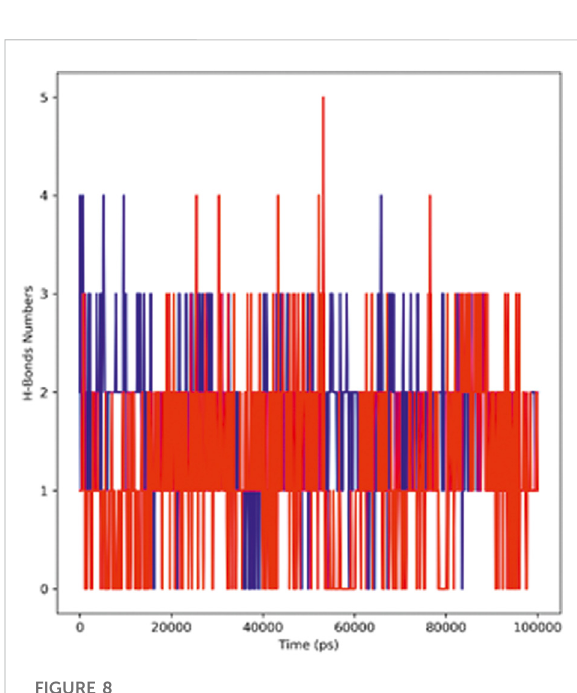
FIGURE 8 Representation of the hydrogen bonding pattern observed for protein – ligand complexes (adapalene – red and tamsulosin – blue) for 100-ns MD